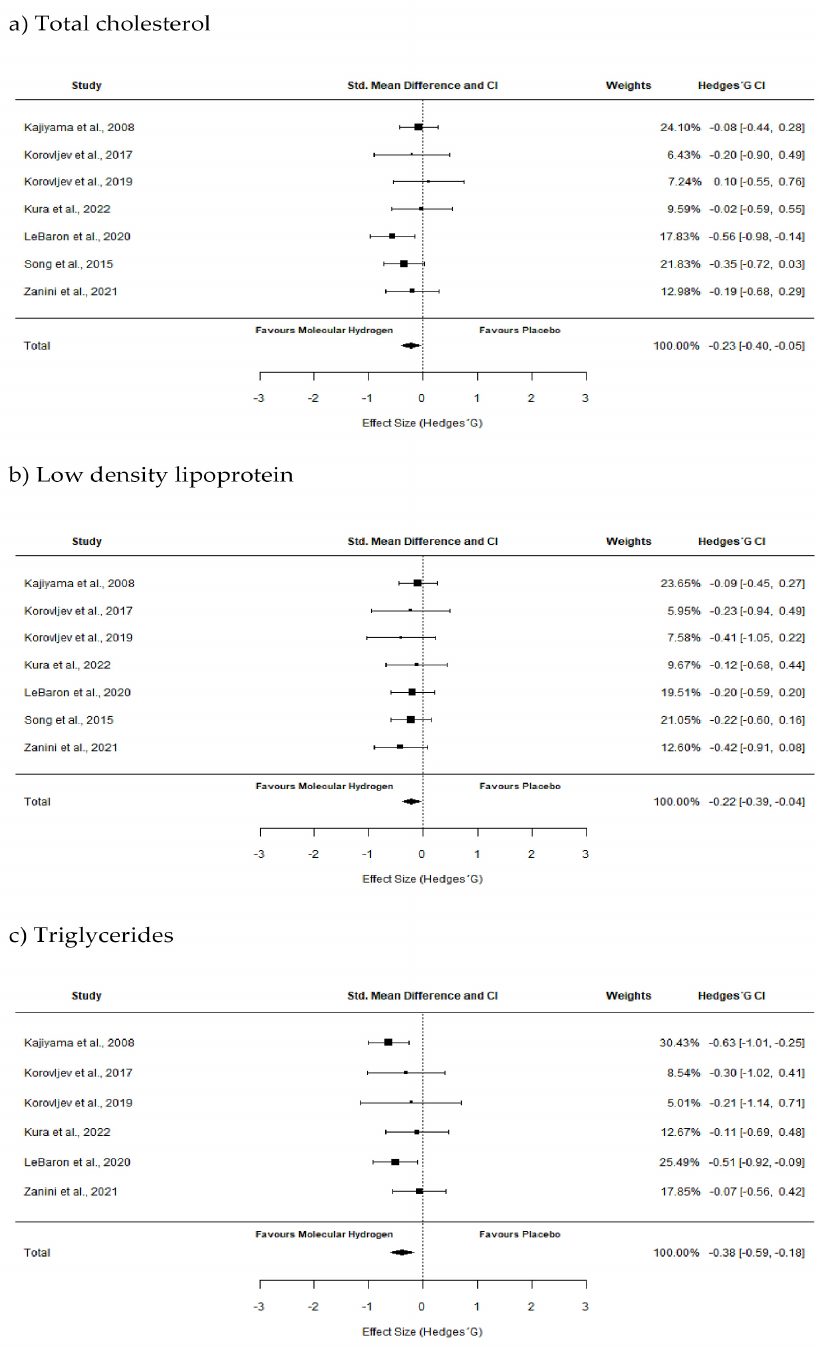
Figure 4. Forest plots of included studies. Forest plot comparing the effects of HRW supplementation on: ( a ) total cholesterol with a small negative effect (pooled SMD = − 0.23 [from − 0.40 to 0.05]; p ≤ 0.01), ( b ) low-density lipoprotein with small effect (pooled SMD = − 0.22 [from − 0.39 to 0.04]; p ≤ 0.01), and ( c ) triglycerides, with a moderate negative effect (pooled SMD = − 0.38 [from − 0.59 to 0.18], p ≤ 0.01). Only for HDL analysis, the results for the pooled meta-analysis showed a non-signif- icant change after HRW supplementation ( p = 0.23), with a trivial negative effect (pooled